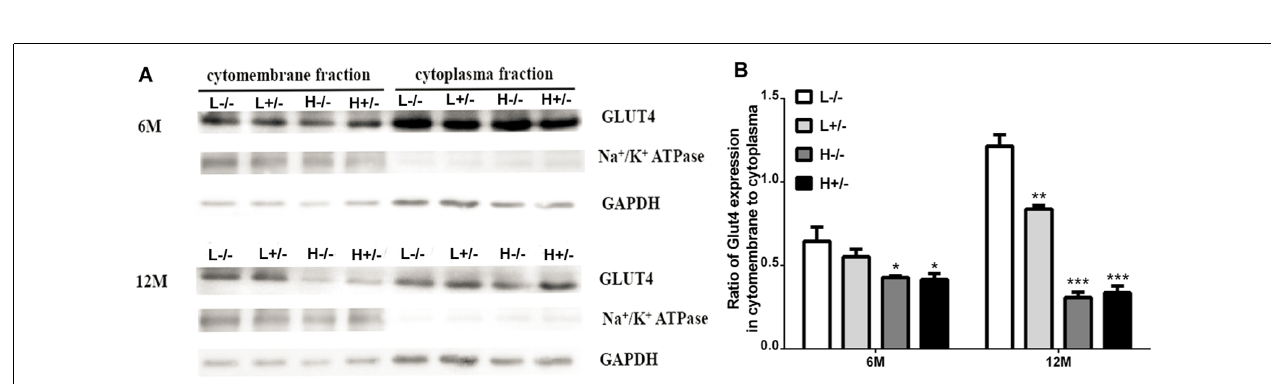
FIGURE 6 | GLUT4 expression in the membrane fractions of the hippocampi of hIAPP − / − and hIAPP + / − mice was reduced by a high-fat diet. (A) Representative images of Western blot analysis. (B) Quantitative analysis was performed on the basis of gray density by using ImageJ software. L − / − denotes hIAPP − / − mice on a low-fat diet; L + / − denotes hIAPP + / − mice on a low-fat diet; H − / − denotes hIAPP − / − mice on a high-fat diet; H + / − denotes hIAPP + / − mice on a high-fat diet. n = 6, ∗ p < 0.05, ∗∗ p < 0.01, ∗∗∗ p < 0.001 compared with the L − / −